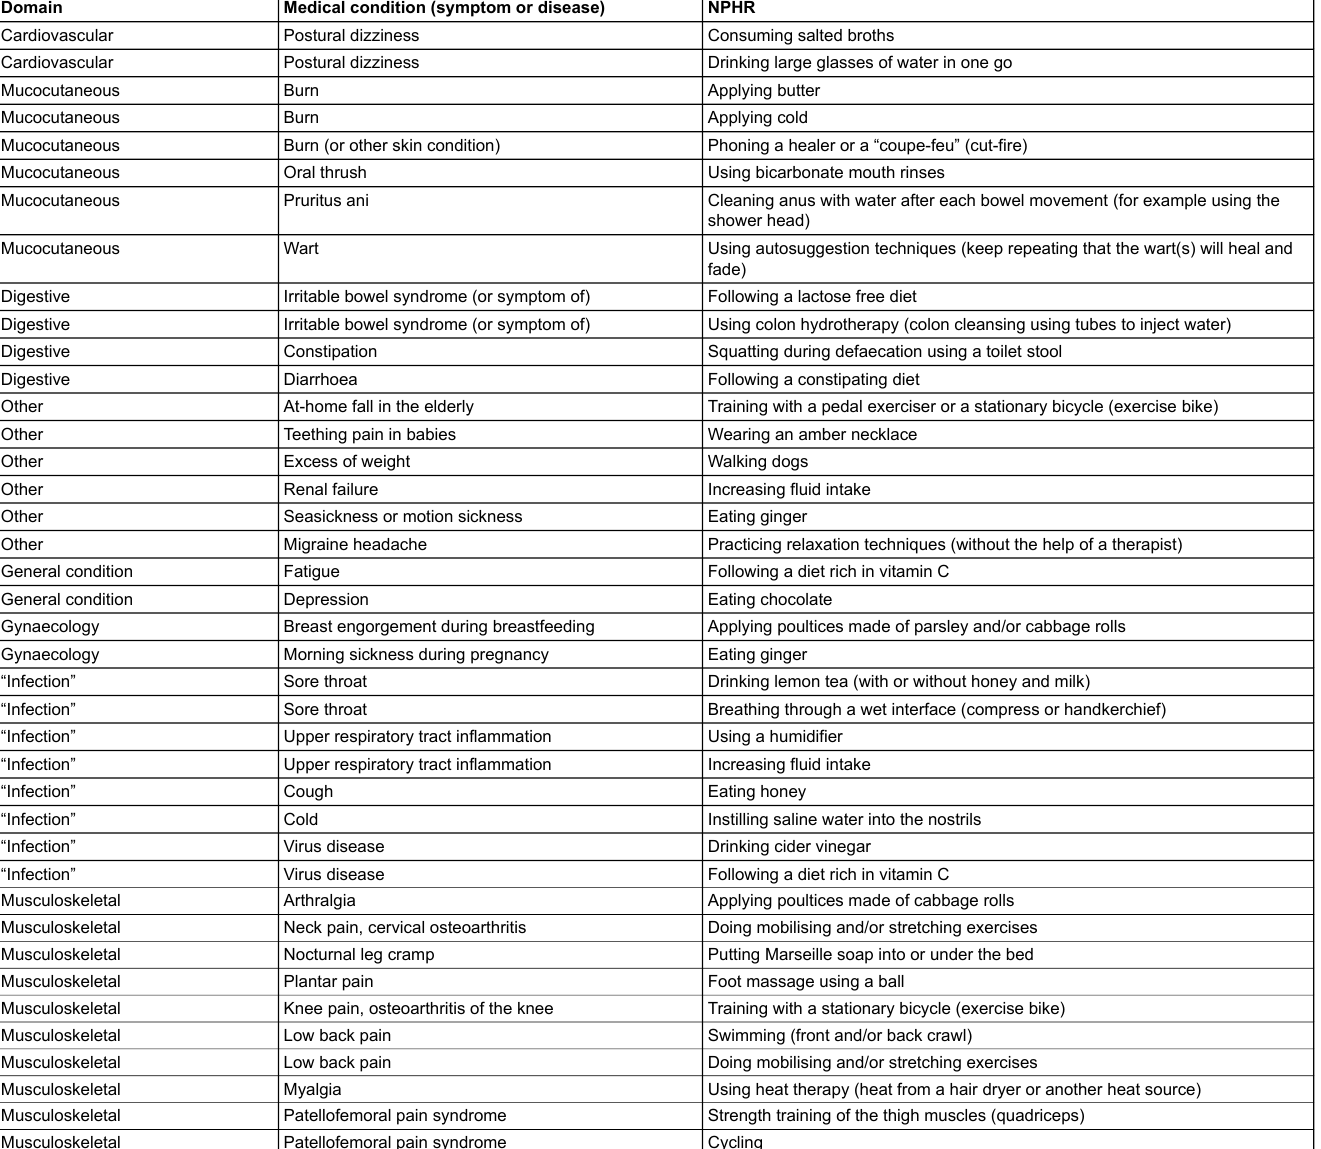
Table S1: List of non-pharmacological home remedies (NPHRs) used in the study.